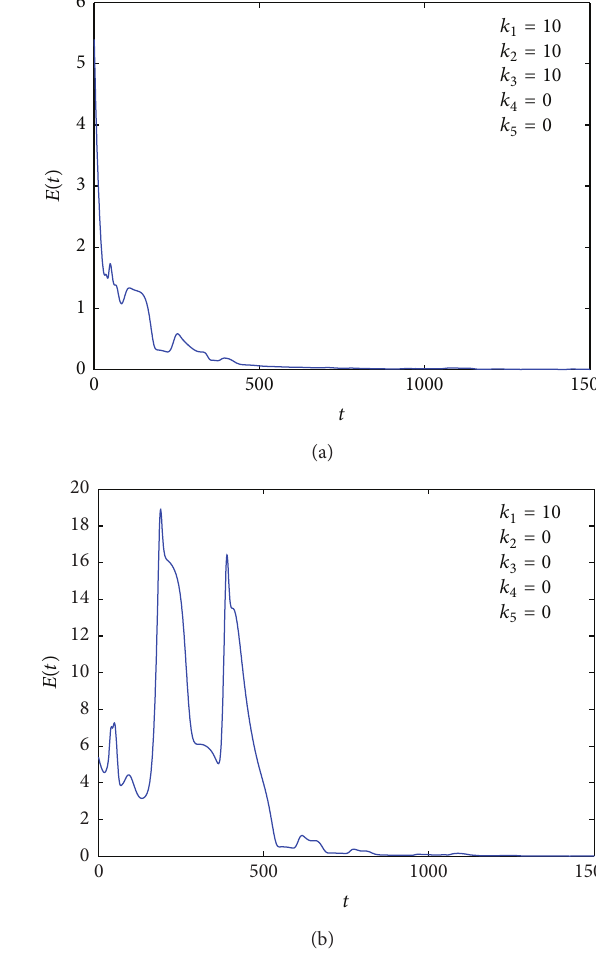
Figure 6: Time evolutions of synchronization error 𝐸(𝑡) with some of 𝑘 𝑖 equal to